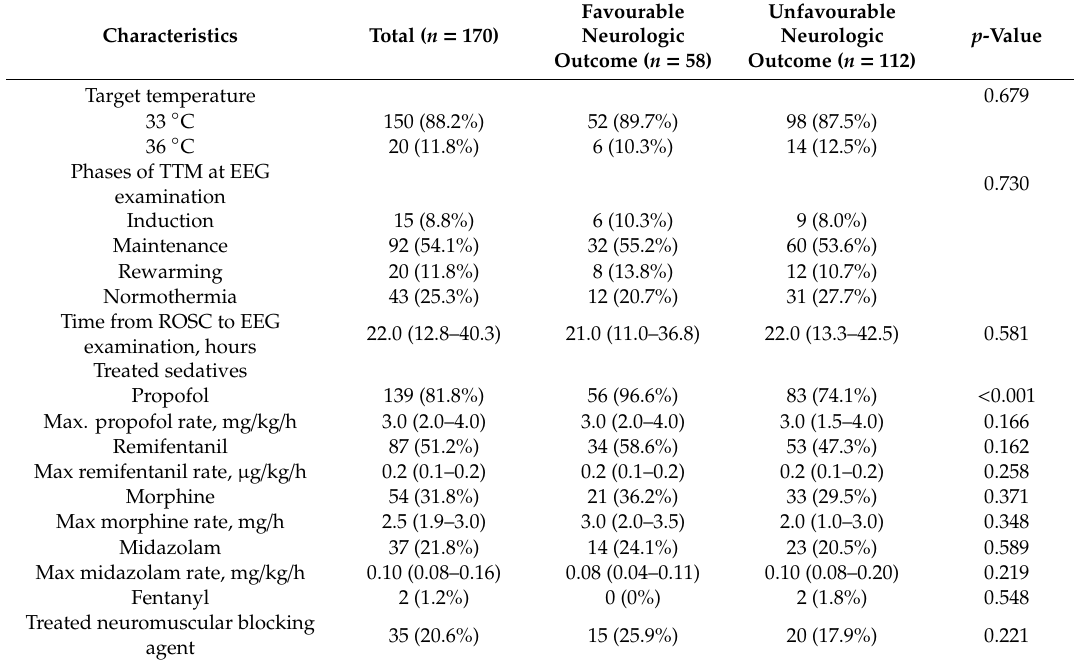
Table 2. Standard intermittent electroencephalography findings based on the standardized terminology of the American Clinical Neurophysiology Society.